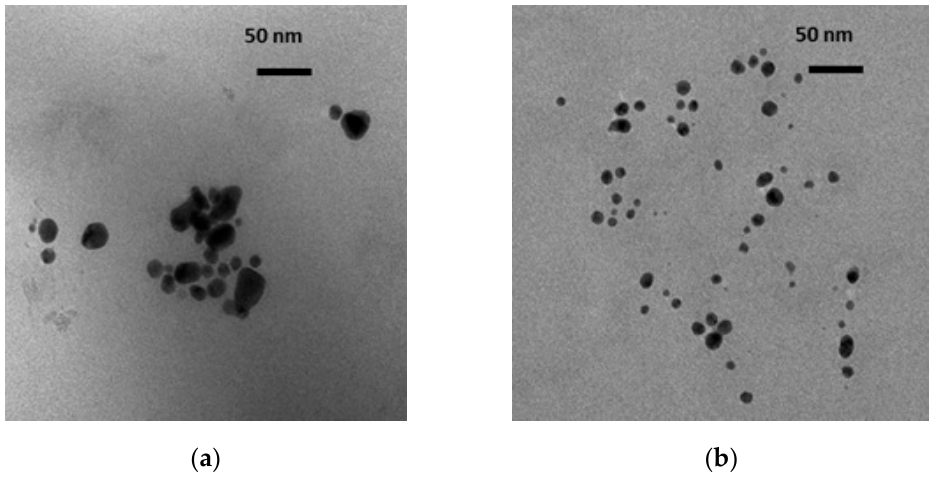
Figure 12. TEM images of AgNPs-H 2 O ( a ) and of AgNPs-EtOH ( b